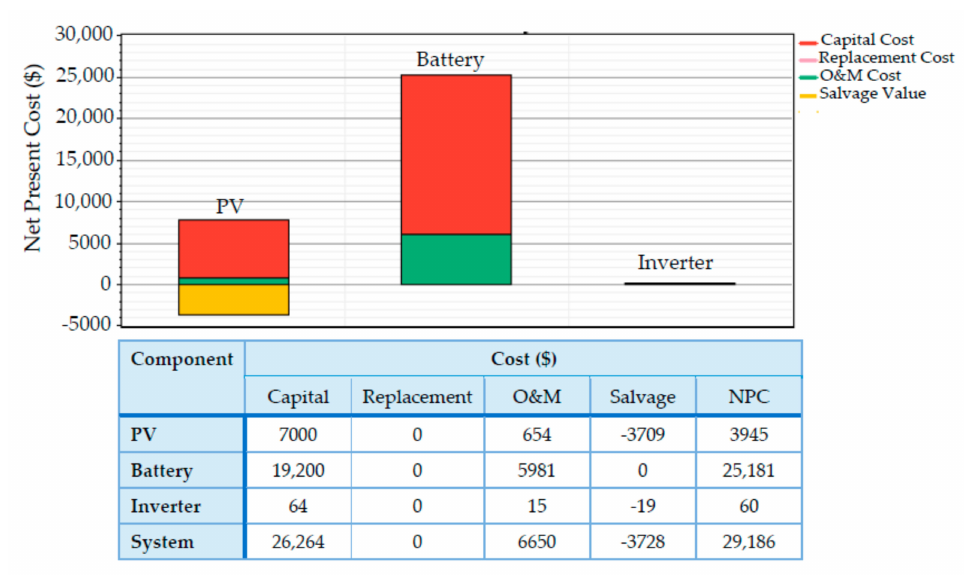
Figure 11. Summary of the net present cost for the system’s